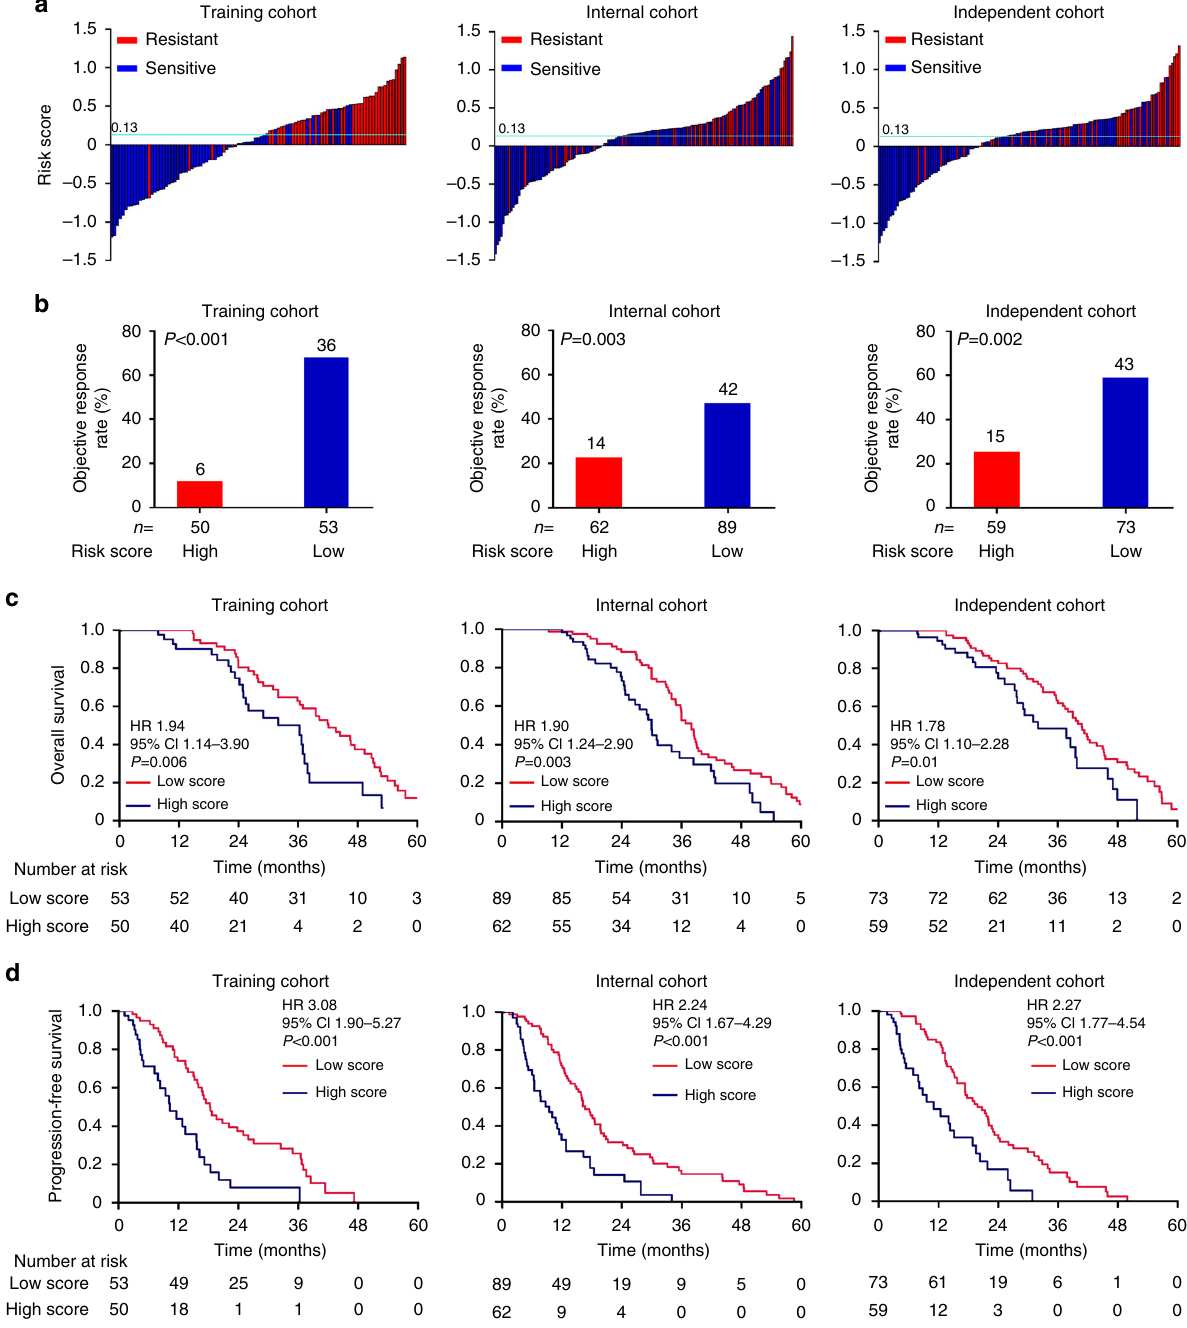
Fig. 2 Distribution of the risk score and response status to trastuzumab treatment in three cohorts. a Waterfall plots for distribution of risk score and response status of individual patients. b Objective response rate between the high- and low-score groups. c Comparison of OS between high score and low score in the three cohorts. d Comparison of PFS between high score and low score in the three cohorts. We calculated hazard ratios (HR) and P -values with an univariate Cox regression analysis and the log-rank test, all statistical tests were two-sided. OS overall survival, PFS progression-free